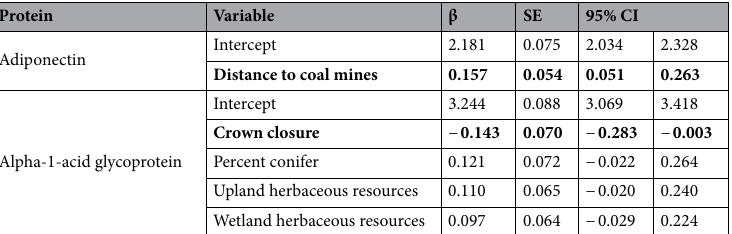
Table 3. Estimate (β), standard error (SE) and 95% confidence interval (CI) of the explanation variables in models with ΔAICc < 2 for the expression of adiponectin and alpha-1-acid glycoprotein in skin samples collected from grizzly bears across Alberta, Canada. Variables with 95% CI that do not cross zero are shown in bold text.